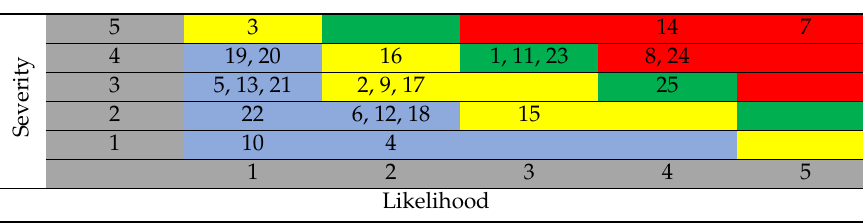
Table 5. Risk Assessment